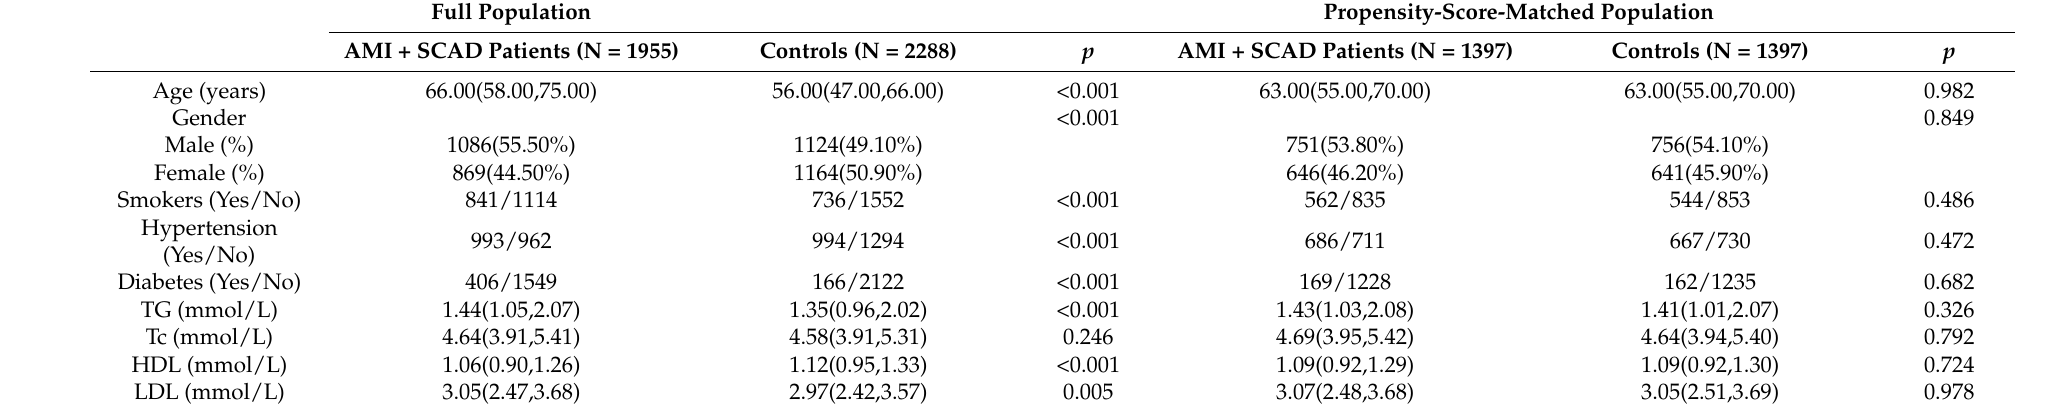
Table 3. Baseline characteristics and AMI + SCAD—control risk factors in the study population.